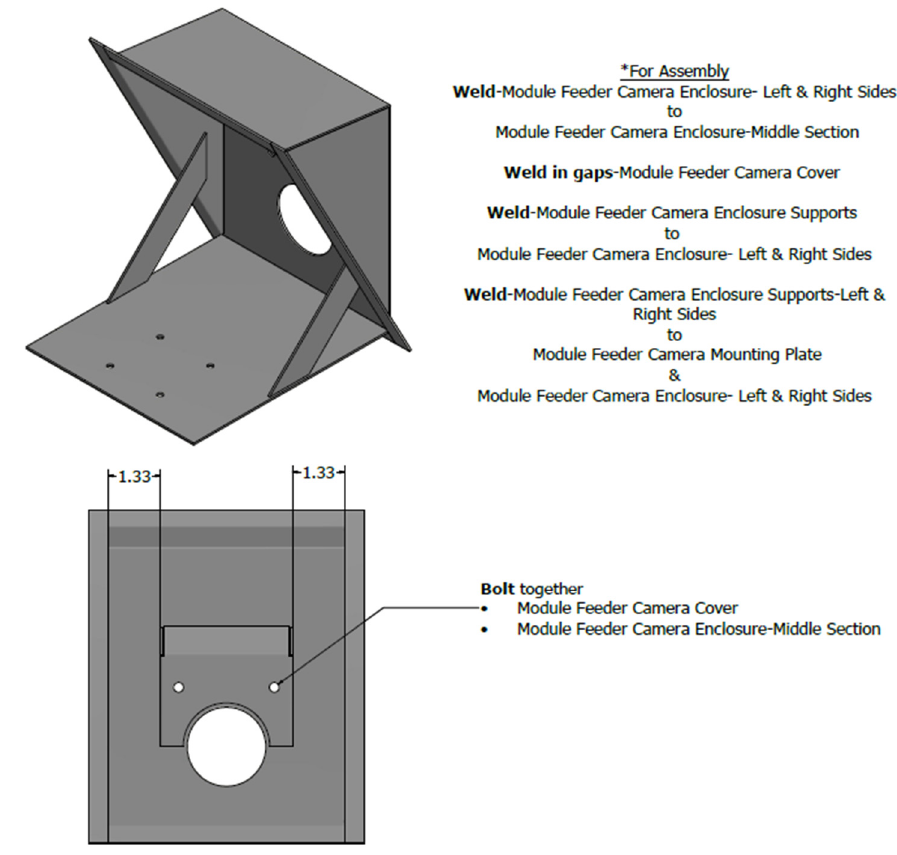
Figure 8. Design drawing of module feeder camera housing (units in inches).